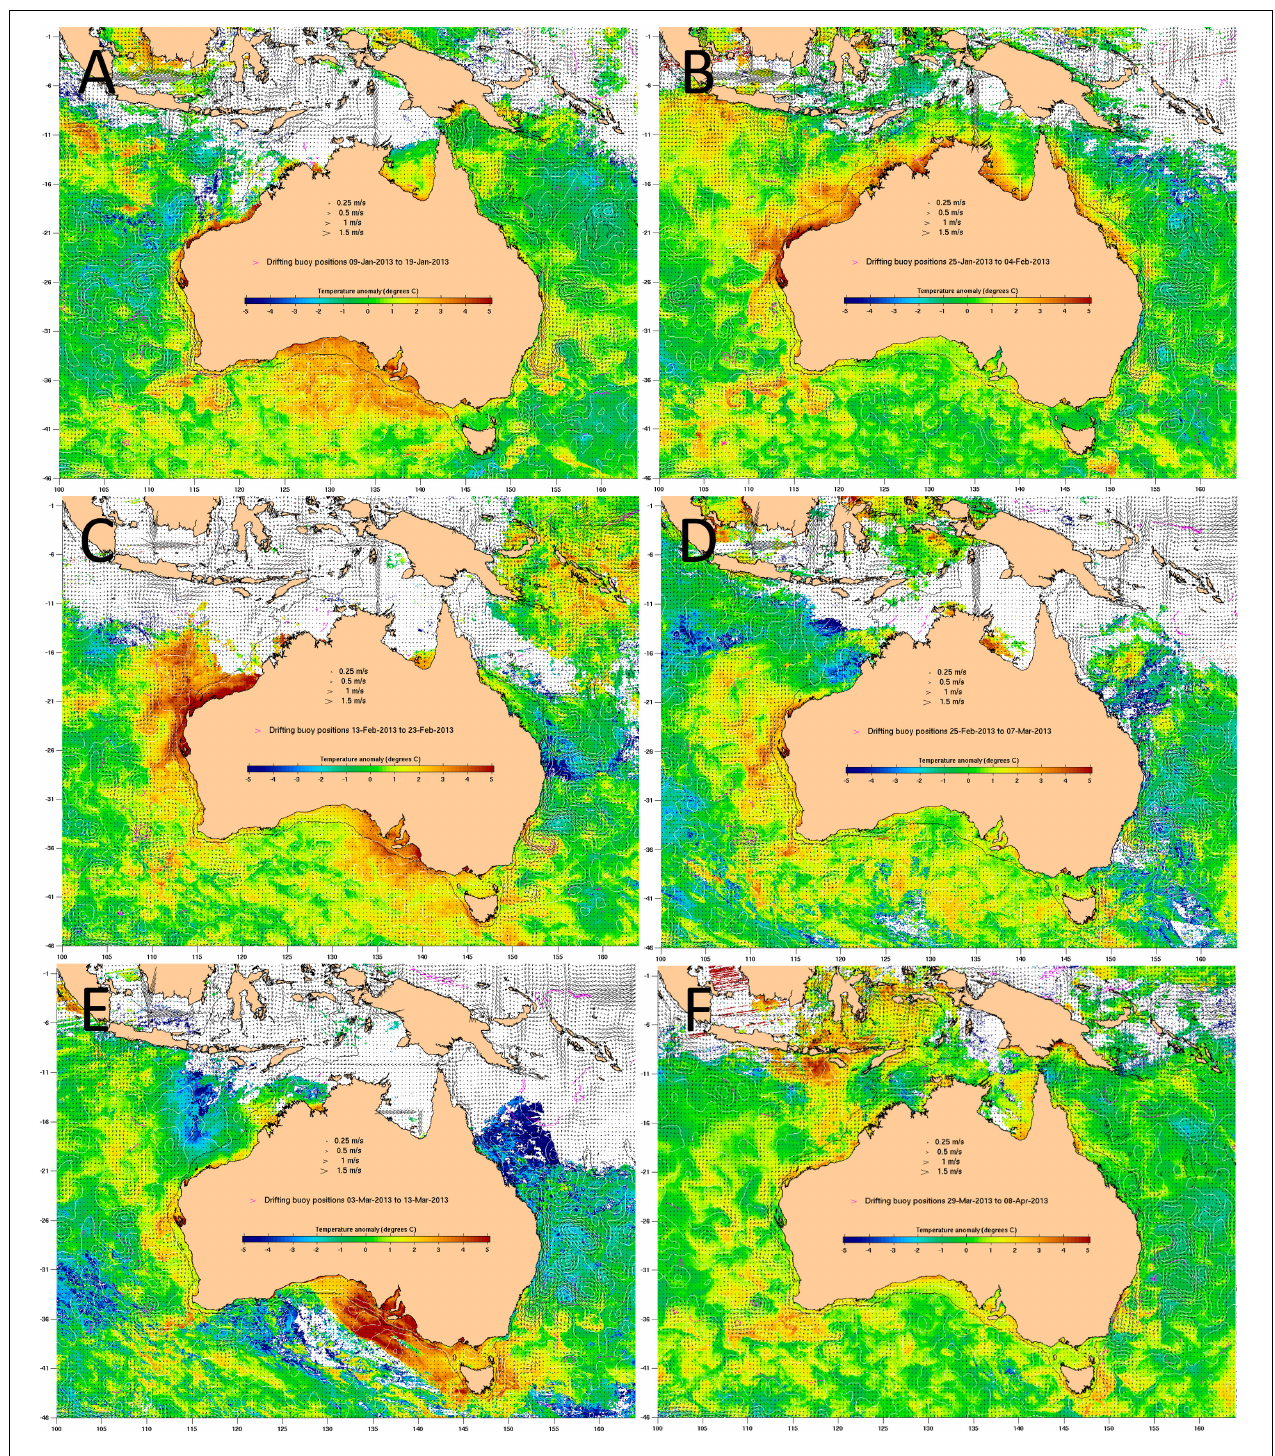
FIGURE 2 | Sea surface temperature (SST) anomaly, which compares a 6-day average SST to the historical average SST at the same time of year, for (A) 12–17 January 2013, (B) 28 January to 2 February 2013, (C) 16–21 February 2013, (D) 27 February to 4 March 2013, (E) 6–11 March 2013 and (F) 1–6 April 2013. SST ranges from colder (–5 ◦ C, blue) than the historical average to warmer (+ 5 ◦ C, red) than the historical average. Source: http://www.cmar.csiro.au/remotesensing/oceancurrent/sst_anom/; accessed June 2019, where the drifting buoy positions for 10 days were used to determine the 6 days SST